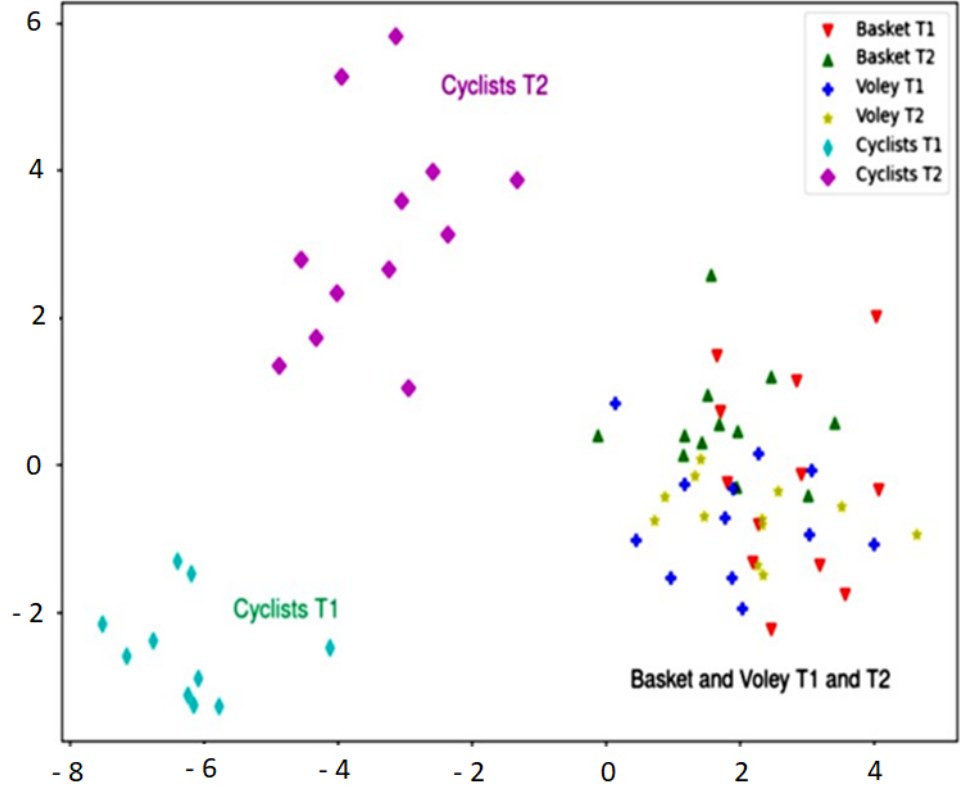
Figure 2. Linear discriminant analysis for cyclist, basketball and volleyball players at T1 and T2.